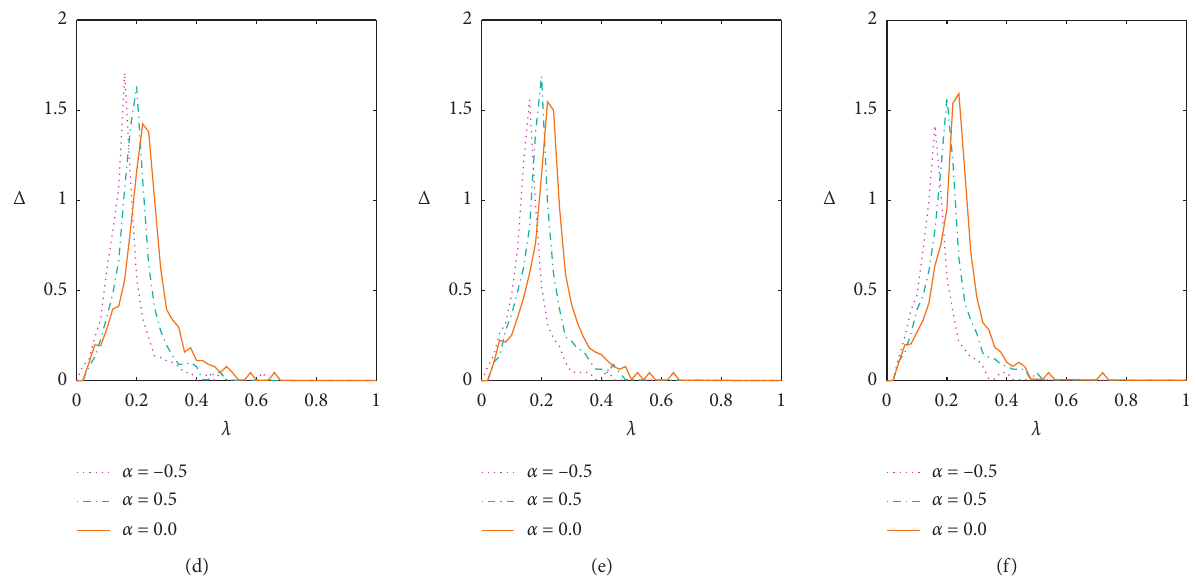
Figure 3: The variation of the outbreak size R ( ∞ ) with the transmission probability λ with different preference selection parameters β . (a) ( β � − 1), (b) ( β � 0), and (c) ( β � 1). The symbols and lines are the simulated and theoretical values of R ( ∞ ) in (a)–(c), respectively, where α � − 0 . 5 (pink triangles), α � 0 . 0 (orange squares), and α � 0 . 5 (blue-green circles). The arrows are theoretical outbreak threshold. The simulated outbreak threshold Δ as a function of λ with β � − 1 (d), β � 0 (e), and β � 1 (f) for the corresponding values of α in (a)–(c), respectively. Another parameter is f � 0 .